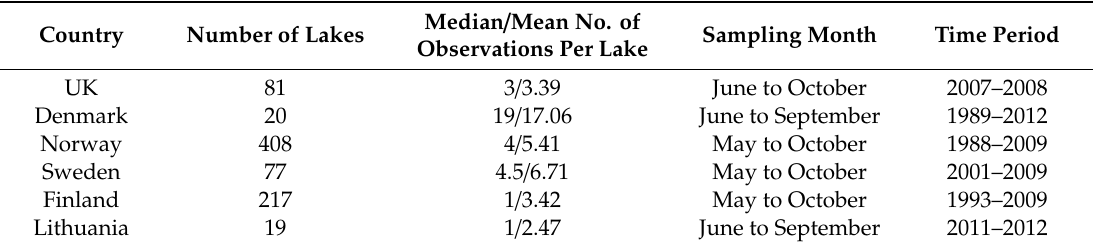
Table 1. Lake dataset geographical distribution, along with the corresponding number of observations, sampling month and yearly